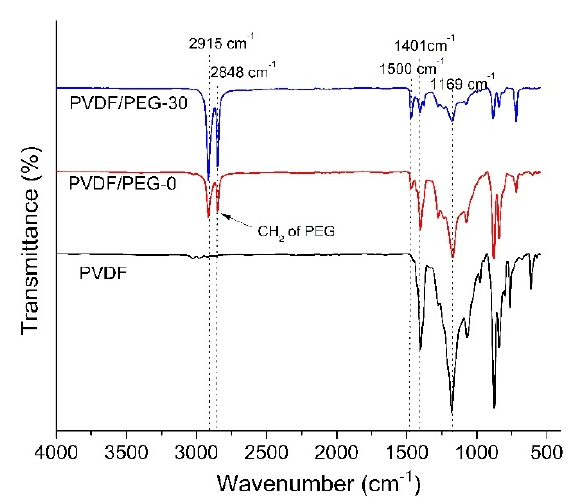
Figure 6. FTIR spectra of the selected membranes.